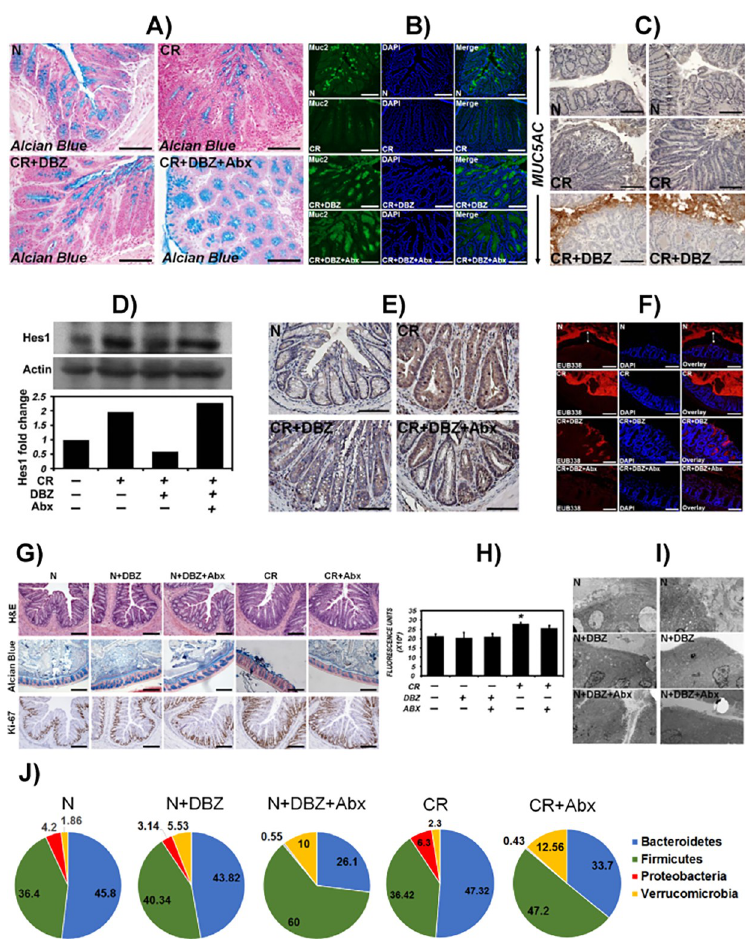
Fig 7. Proof-of-concept experiments to confirm Notch blockade in response to γ -secretase inhibitor, Dibenzazepine (DBZ). NIH: Swiss mice were infected with CR and treated with DBZ, i.p. @ 10 μ mol/Kg body weight or DBZ+ antibiotics (Abx) (1g/l metronidazole and 0.2 g/l ciprofloxacin) for 10 days. A, B. Paraffin sections prepared from uninfected (N), CR-infected (CR), CR+DBZ-treated and CR+DBZ+Abx-treated mice were stained with Alcian blue (A) and Muc-2 (B) to detect goblet cells. C. Paraffin sections from uninfected (N), CR-infected (CR) and CR +DBZ-treated mice were stained for MUC5AC. Bars (A-C) = 150-200 μ m; n = 3 independent experiments. D. Western blot showing relative abundance of Hes-1 in crypt extracts prepared from the indicated groups. Bar graph shows fold change in Hes-1 levels (n = 1). E. Representative immuno-staining for Hes-1 in the sections prepared from the indicated groups. Bar = 125 μ m; n = 3 independent experiments. F. Representative fluorescence microscopy to detect bacteria in the unflushed and Carnoy-fixed colonic tissues of N, CR, CR+DBZ and CR+DBZ+Abx-treated mice via FISH using a general bacterial 16S probe (TexasRed-Eub338; Bar = 100 μ m; n = 10 mice/group). DAPI was used as counter-stain. Two-sided arrows represent the distance between the bacterial staining and the epithelial monolayer. G-J. Control experiments in uninfected (N) mice treated with DBZ or DBZ+Abx and CR-infected mice treated with Abx . Indicated analyses including H&E, Alcian Blue and Ki-67 staining (G; bar = 75 μ m), FITC-D measurement as fluorescence units (H; � p < 0.05), electron microscopy (I) and 16S sequencing at the phyla level (J) were performed. n = 3 independent experiments.